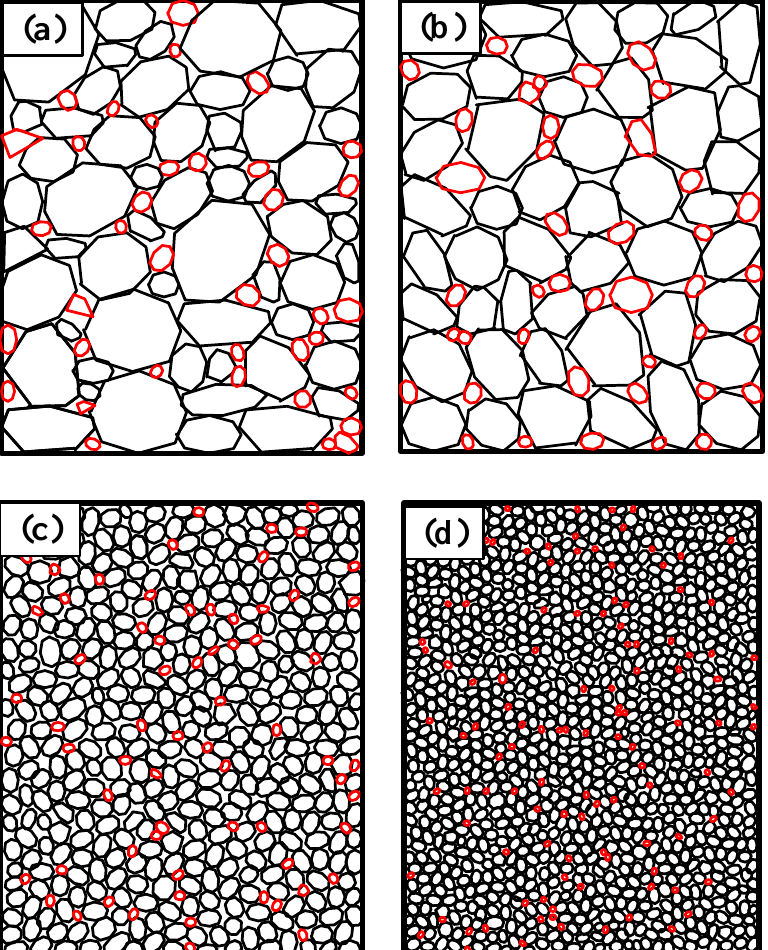
Figure 15. Abstract diagram of the structure of briquettes with different particle sizes: ( a ) group A, ( b ) group B, ( c ) group C and ( d ) group D.